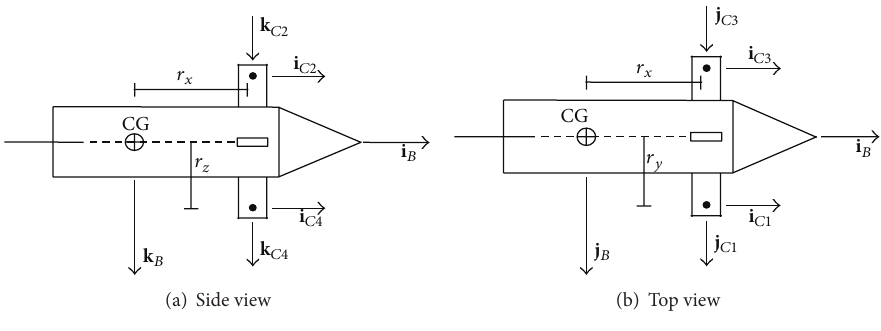
Figure 1: Basic geometrical data of the proposed projectile.